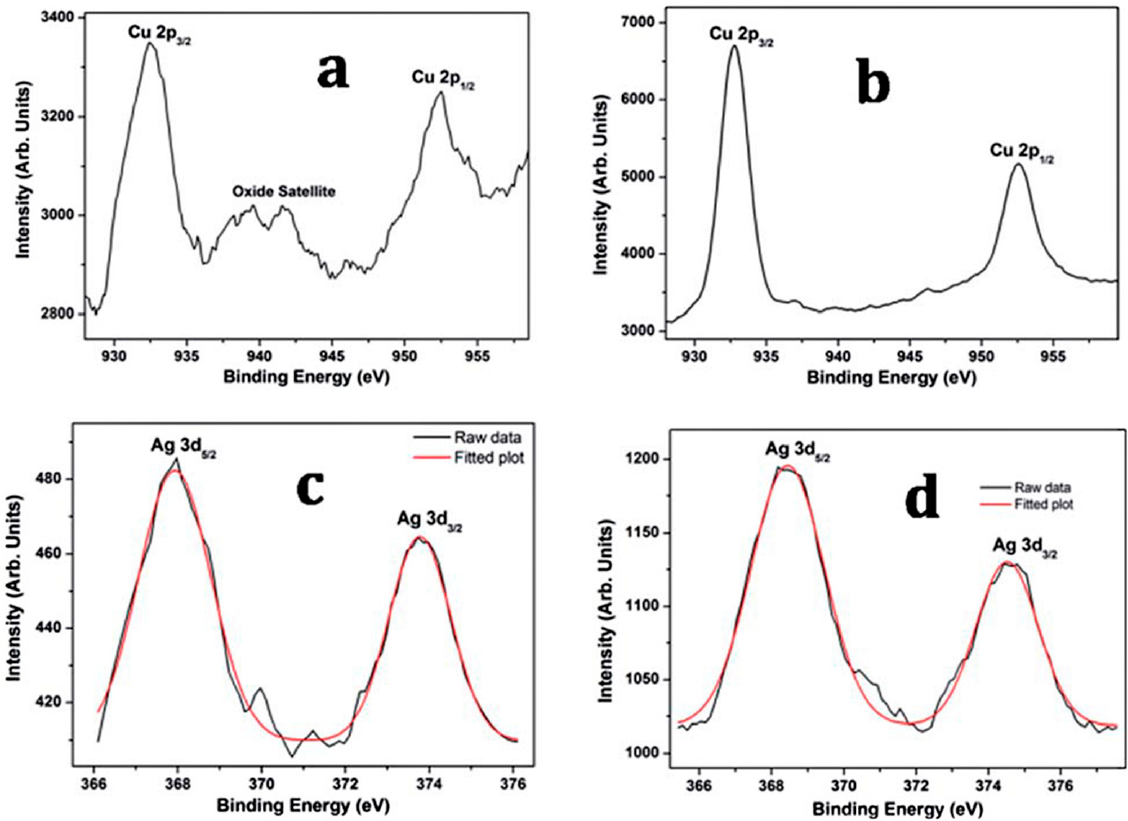
Figure 16. XPS spectra of Cu2p ( a ) before and ( b ) after sputtering, and Ag3d ( c ) before and ( d ) after sputtering, in Ag shell Cu core nanoalloy. Reproduced with permission from Reference [262]. Copyright 2015, Royal Society of Chemistry.